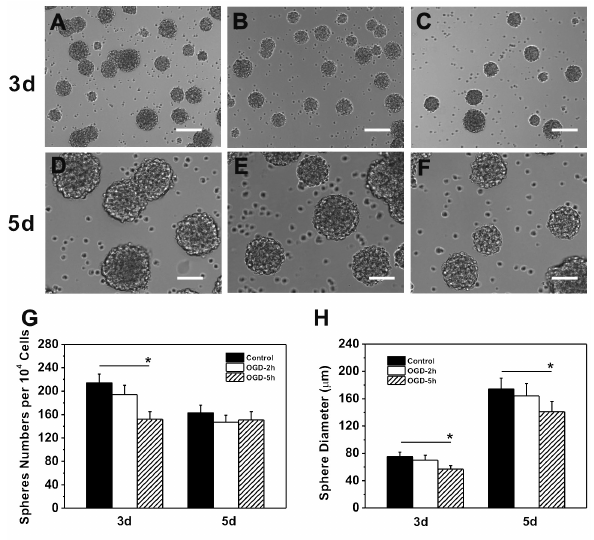
Figure 4. The formation of NSC neurosphere under OGD treatment. (A-F) The bright field photos of the neurospheres for three or five days of culture under OGD treatment for 2 h and 5 h. The number of neurospheres generated per 104 NSCs (G) and the average sphere diameter (H) in control, OGD-2 h and OGD-5 h groups for culturing three or five days. Scale bar = 100 µm. Data were presented as mean ± S.E.M. *p < 0.05 vs control.